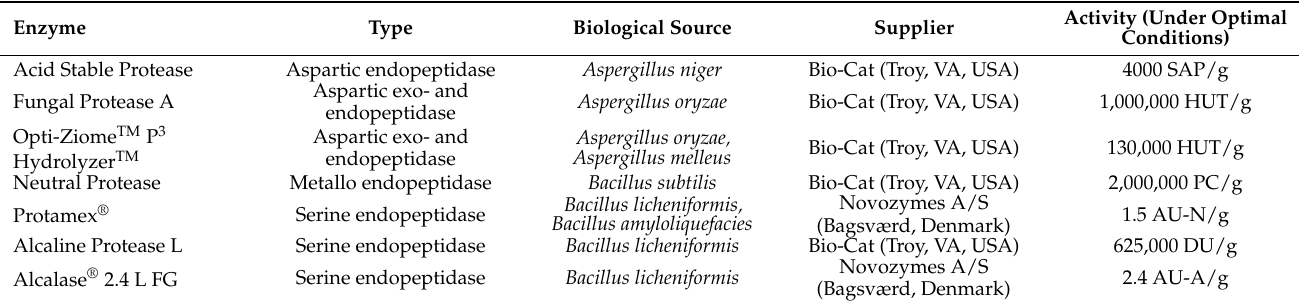
Table 1. Sources and properties of the commercial enzymes